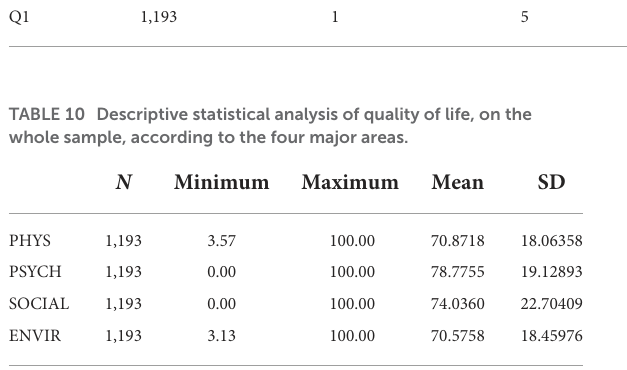
TABLE 9 The participants’ answer to the question “How do you rate your quality of life during the conflict in Ukraine?” N Minimum Maximum Mean SD Variance Statistic Statistic Statistic Statistic SE Statistic Statistic